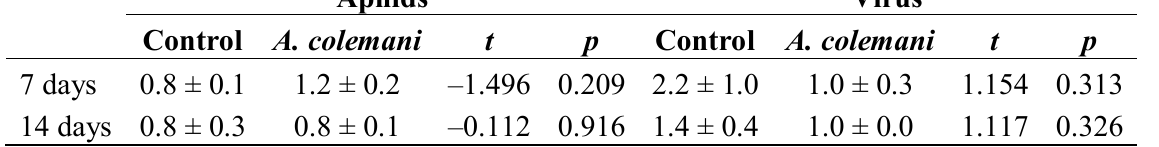
Table 6. Mean ± S.E. values of the displacement ( δ ) of aphids and CABYV after 7 and 14 days in arenas with and without (control) A. colemani , followed by statistics according to Student’s t test ( p <